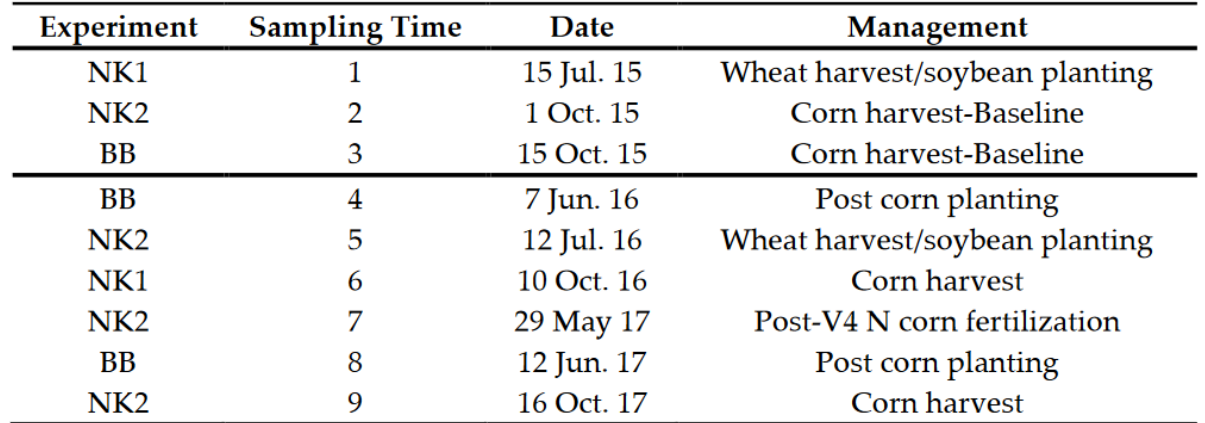
Figure 1. Chronological chart with the detail of the full crop rotations and the gas sampling protocol for Blacksburg and New Kent (NK1 and NK2) sites in Virginia ( top ); information including sequential sampling order, effective date of sampling and main crop management milestone at the time of gas sampling for each study ( bottom